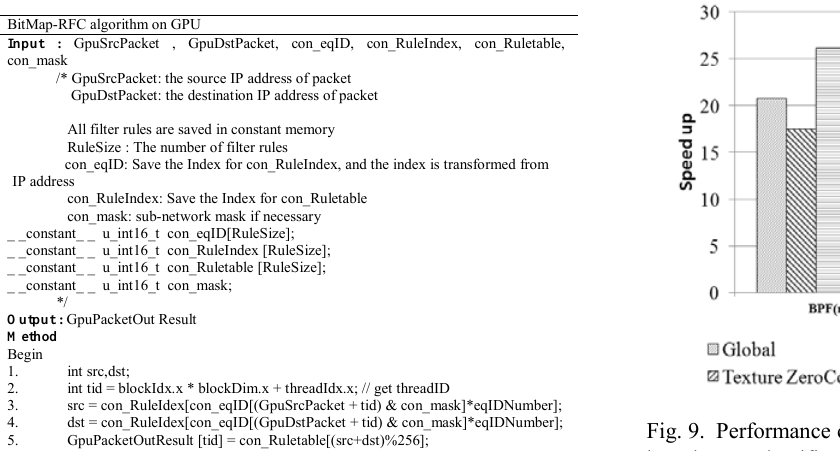
Fig. 9. Performance comparison between CPU-based and GPU- based BPF classification algorithms with a variety of memory